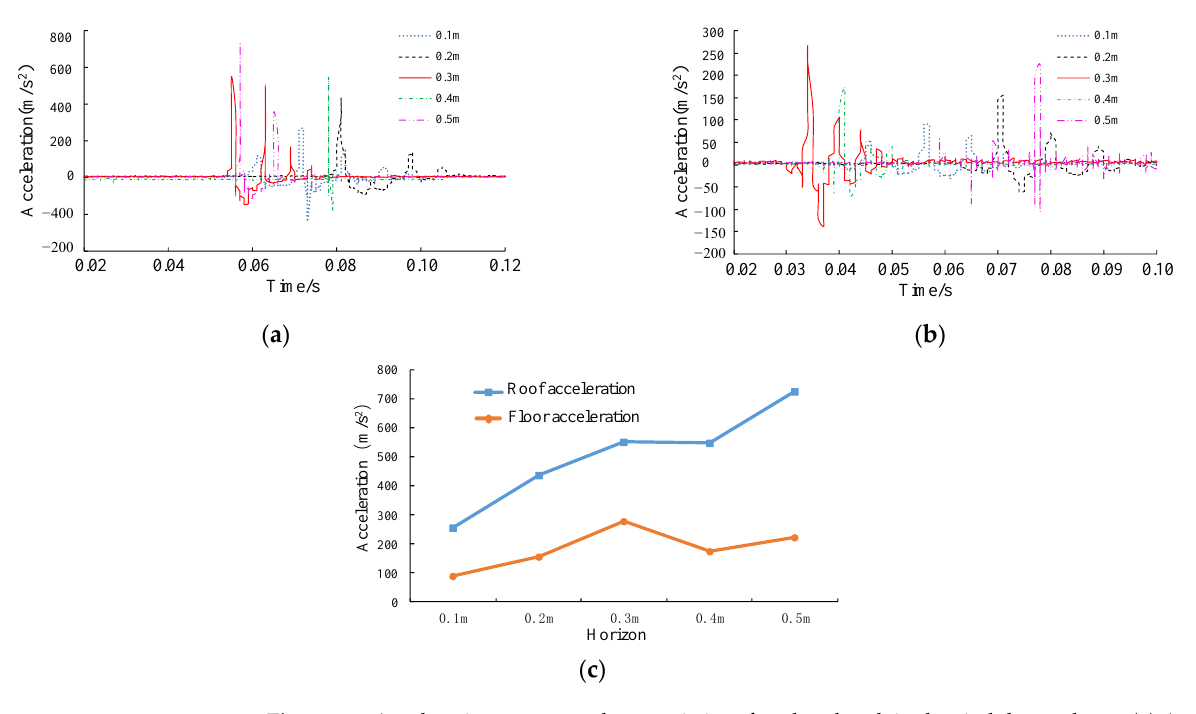
Figure 12. Acceleration response characteristics of coal and rock in the fifth layered test. ( a ) Accel- eration at the roof of surrounding rock; ( b ) Acceleration at the bottom of the roadway; ( c ) Peak ac- celeration at different energies.